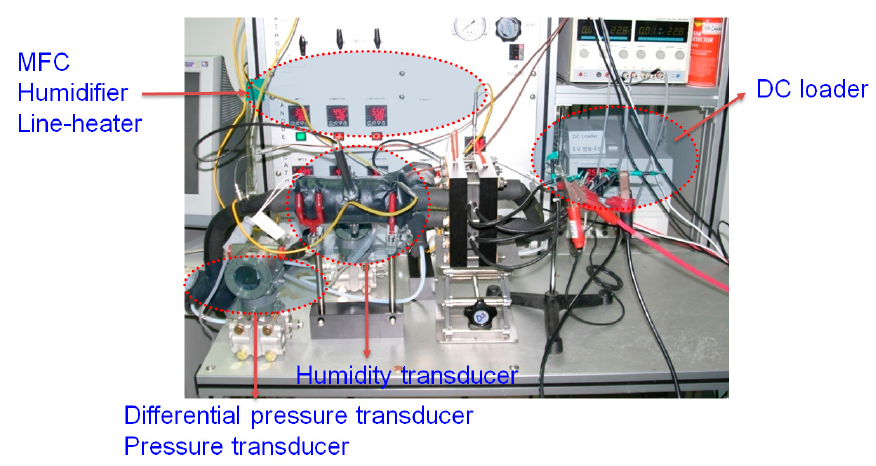
Figure 3. Experimental unit of the fuel cell.